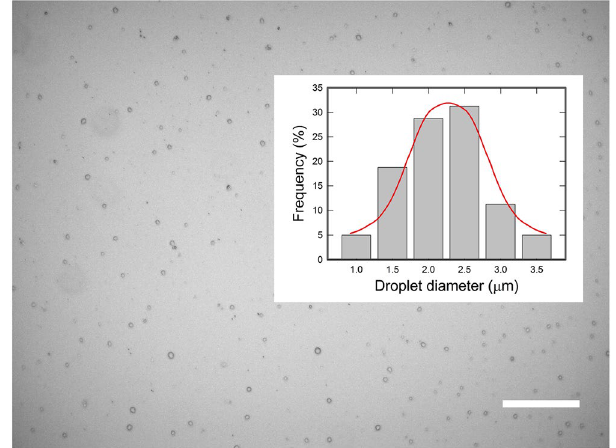
Figure 4. Drops of DI water in paraffin oil obtained in the high-frequency pulsation mode. The scale bar is 50 µ m (Inset: size